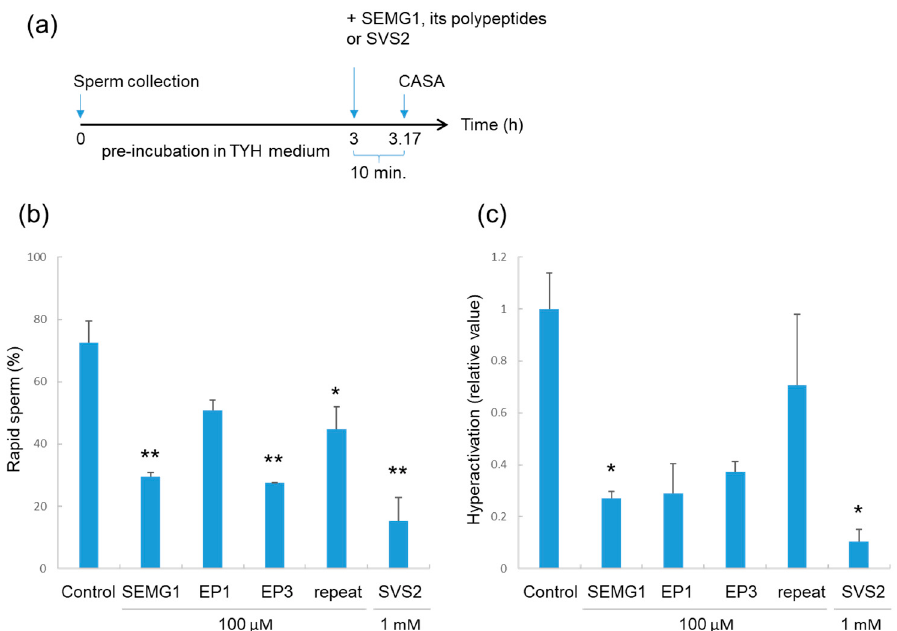
Figure 4. E ff ect of sperm protective agents on sperm motility after pre-incubation. ( a ) Experimental design for testing short exposure with five factors on sperm motility after 3 h incubation. ( b ) Rates of epididymal sperm displaying rapid motility after 3 h of pre-incubation ( n = 3). Data are expressed as the average ± standard error of the mean. * p < 0.05 and ** p < 0.01, compared with control sperm. ( c ) Rates of epididymal sperm displaying hyperactivated movement after 3 h of pre-incubation ( n = 3). Data are expressed as the average ± standard error of the mean. * p < 0.05, compared with control sperm.